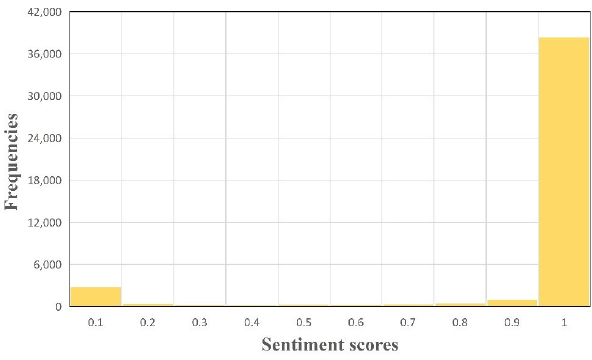
Figure 5. The sentiment scores and frequencies of urban parks’ online reviews.